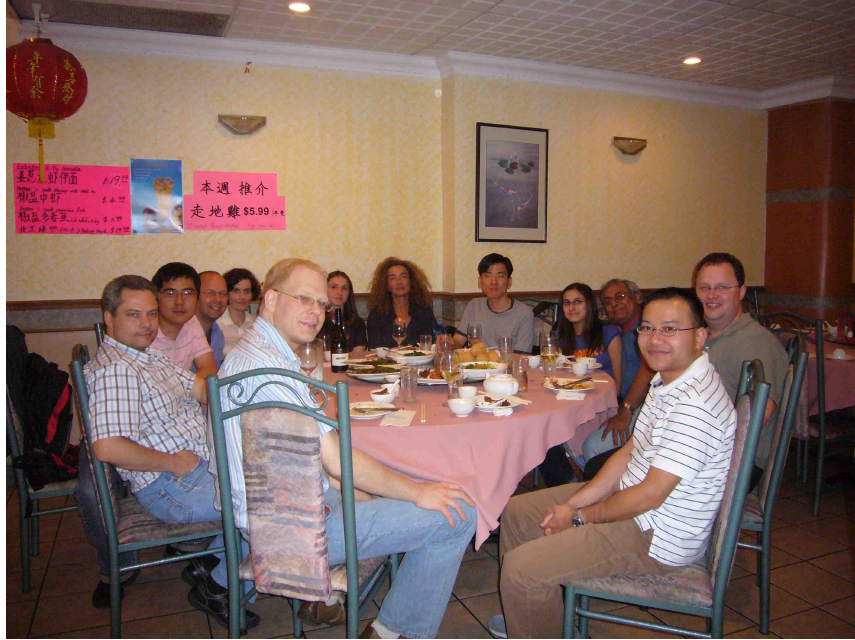
Figure 4 – People in the picture are: Erhard Cramer, Marco Burkschat, George Iliopoulos, Peng Zhao, Bruno Scarpa, Anna Dembinska, H.K. Tony Ng, Donghoon Han, Katherine Davies, An- tonella Capitanio, Sarah Balakrishnan, Narayanaswamy